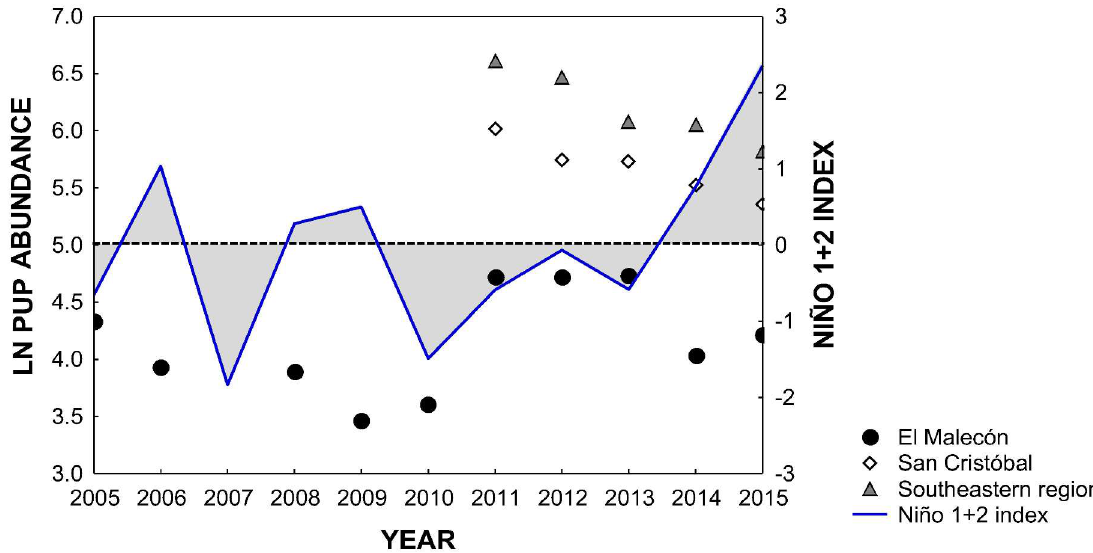
Fig 4. Pup abundance of Galapagos sea lions for El Maleco´n, San Cristo´bal and the entire southeastern region of the archipelago per year in relation to the Ni ñ o 1+2 index. The Ni ñ o1+2 index is the three-month runningmean of the sea surface temperature (SST) anomaliesin the Ni ñ o 1+2 region(0–10˚S, 90–80˚W). The values of the Ni ñ o 1+2 index plotted for each year correspond to the averageof five months of data (from August to December)and were taken from the NOAA website. The Ni ñ o 1+2 index indicates the intensity of El Ni ñ o (positivevalues) and La Ni ñ a (negative values) events, which can be consideredweak (SST anomalyof 0.5 to 0.9), moderate (1.0 to 1.4) or strong ( (cid:21)